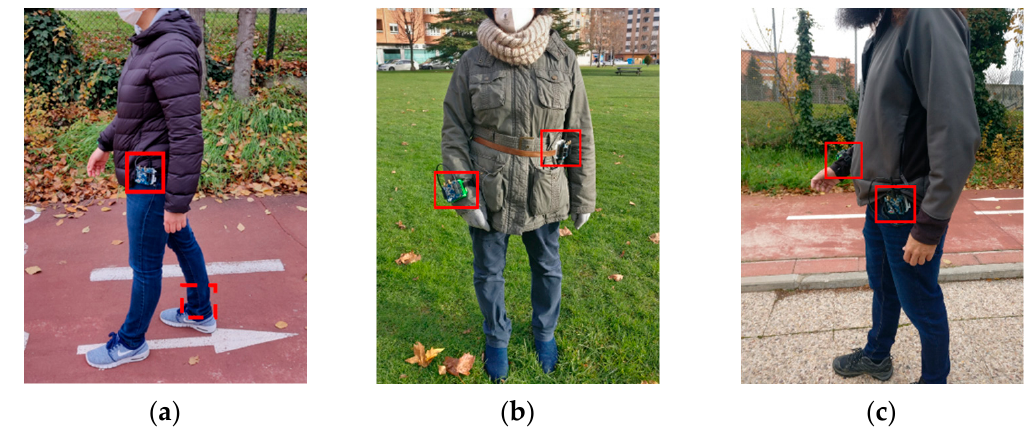
Figure 4. Subjects of the walking scenario at various points in the experiment: ( a ) Subject A, ( b ) Subject B and ( c ) Subject C.